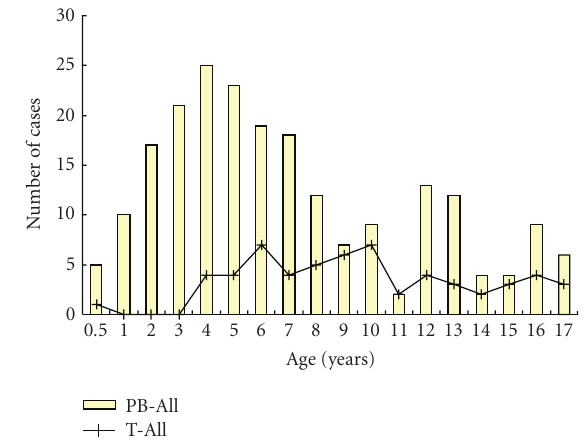
Figure 1: Age distribution of 275 children with acute lymphoblastic leukemia